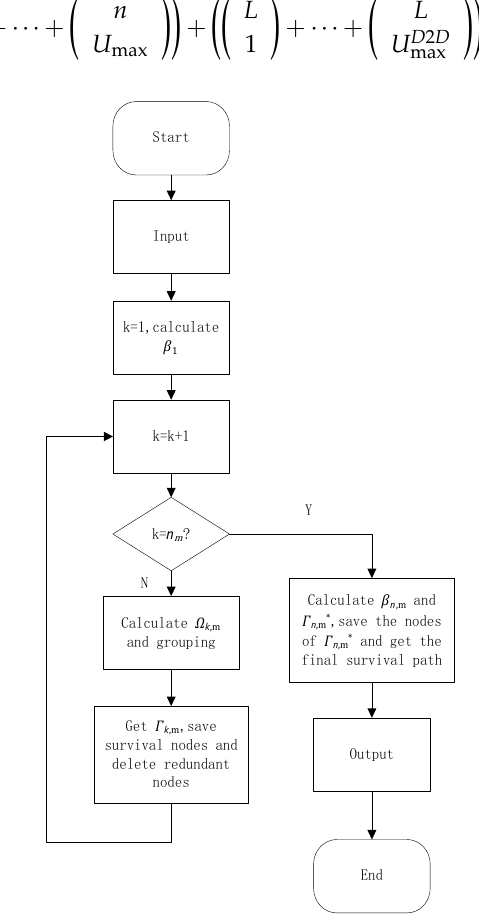
Figure 3. Flow chart of the tree-based search power allocation algorithm (TSA).